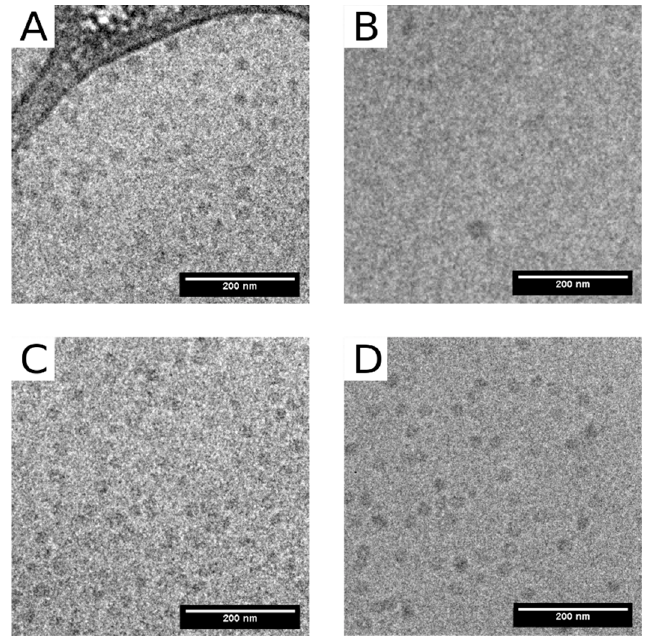
Figure 4. Cryo-TEM images of BMV-based VLPs. ( A ) Empty VLPs obtained from wt CP (eVLPs). ( B ) Empty VLPs obtained from mutated CP (eMVLPs). ( C ) VLPs obtained from wt CP with tRNA (tVLPs). ( D ) VLPs obtained from mutated CP with tRNA (tMVLPs).